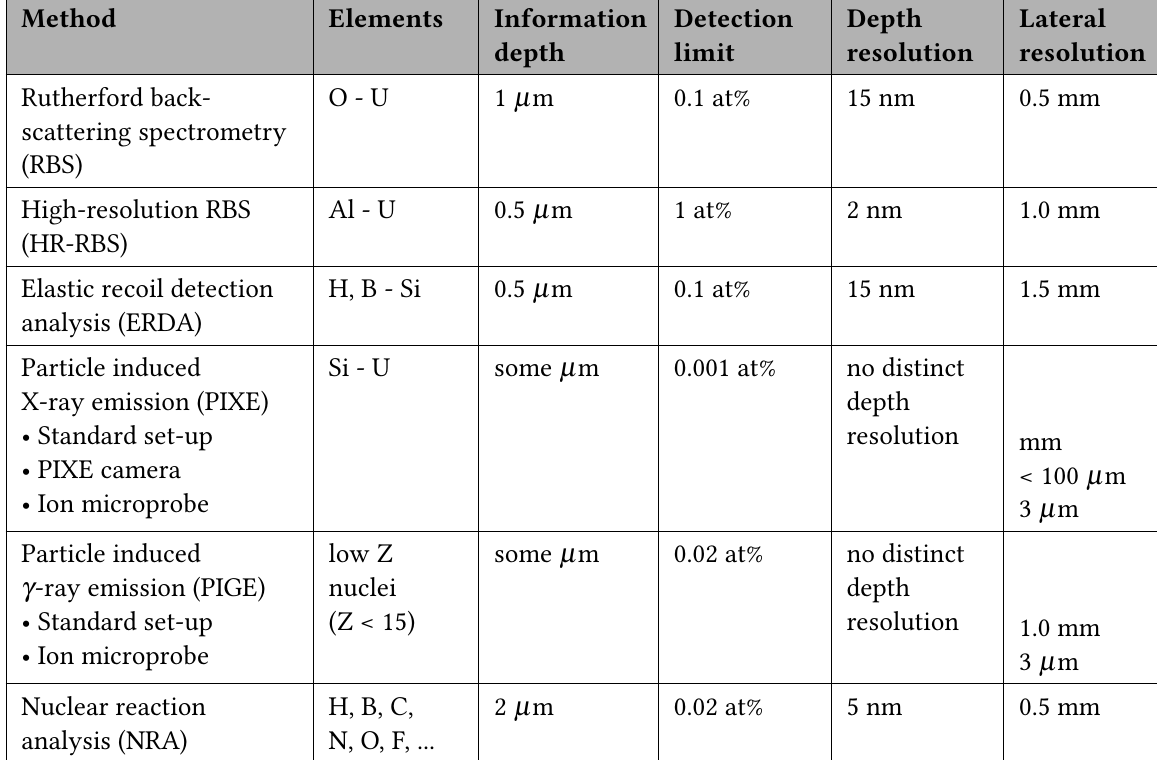
Table 2: Basic parameters of IBA techniques available at